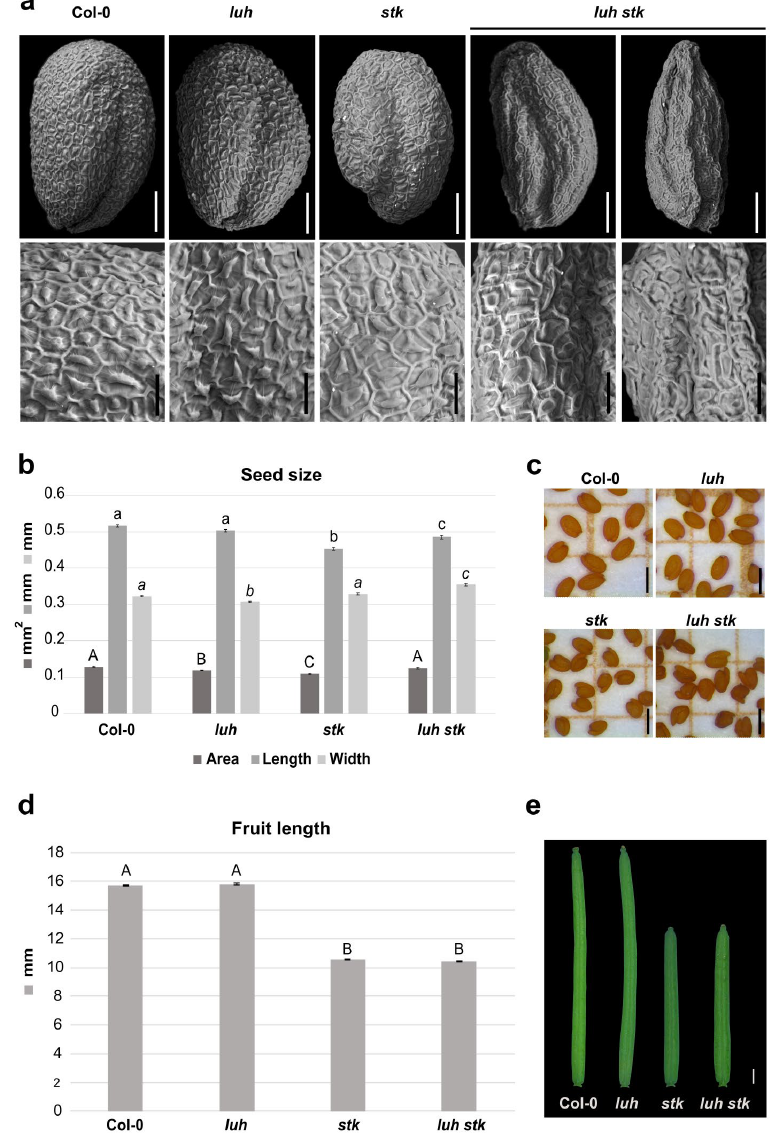
Figure 2. Morphological effects of luh stk double mutant on seed and silique development. ( a ) Scan- ning Electron Microscopy (SEM) pictures of seeds from Col-0 (WT), luh , and stk single mutants as well as luh stk double mutant. In the upper part, the whole seeds are shown, scale bar = 100 µ m; in the bottom part, pictures with a zoom of the seed surface are shown, scale bar = 20 µ m. ( b ) Histogram representing the seed size of WT, luh , stk, and luh stk, with mean of the seed area (mm 2 ), length (mm), and width (mm). Error bars represent the SE of one representative biological replicate of n = 50 seeds. Statistical analyses were performed using ANOVA followed by Tukey’s HSD test. Different letters indicate statistically significant differences ( p < 0.01) between WT and the other genotypes, and between single mutants and the double mutant. ( c ) Stereomicroscope images of seeds from WT, luh , stk, and luh stk . Scale bar = 0.5 mm. ( d ) Histogram representing the silique length of WT, luh , stk, and luh stk . Error bars represent the SE mean of one representative biological replicate of n = 10 siliques for each genotype. Statistical analyses were performed using ANOVA followed by Tukey’s HSD test. Different letters indicate statistically significant differences ( p < 0.01) between WT and the other genotypes and between single mutants and the double mutant. ( e ) Stereomicroscope images of silique from WT, luh , stk, and luh stk . Scale bar = 1